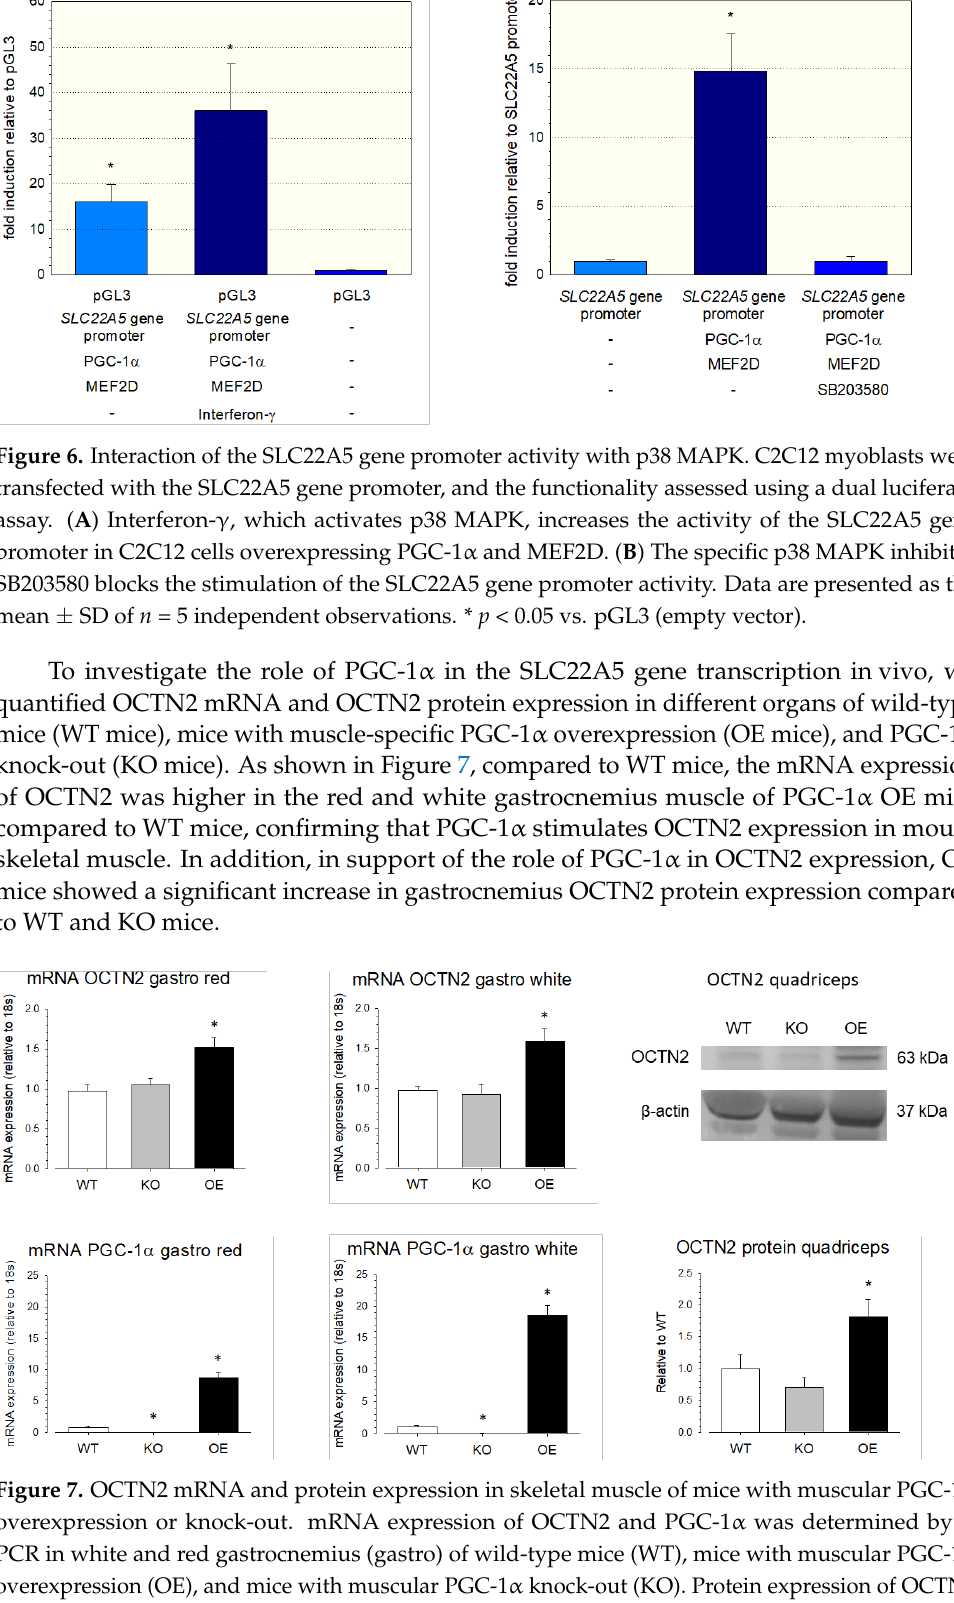
Figure 7. OCTN2 mRNA and protein expression in skeletal muscle of mice with muscular PGC-1 α overexpression or knock-out. mRNA expression of OCTN2 and PGC-1 α was determined by rt PCR in white and red gastrocnemius (gastro) of wild-type mice (WT), mice with muscular PGC-1 α overexpression (OE), and mice with muscular PGC-1 α knock-out (KO). Protein expression of OCTN2 was determined by Western blotting in the quadriceps of the same groups of mice. Data are presented as the mean ± SD of n = 4 independent observations. * p < 0.05 vs. WT mice.